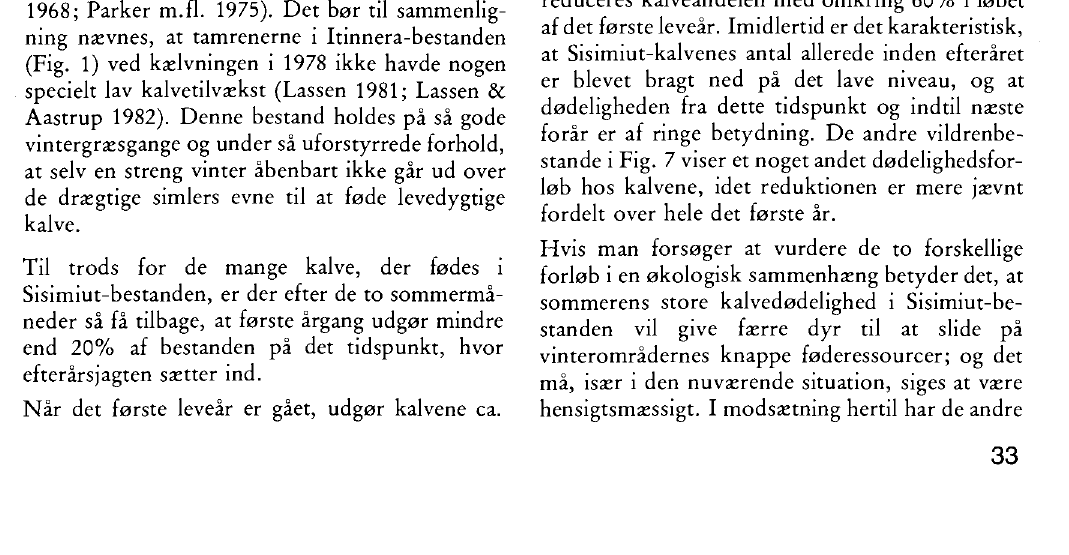
Fig. 7. Det gennemsnitlige kalv/simle forhold i Sisimiut- bestanden og i 12 forskellige vildrenbestande fra Canada, Alaska og Norge samt ændringer gennem første leveår. Ternede søjler = Sisimiut-bestanden. Prikkede søjler = 12 forskellige bestande fra Canada, Alaska og Norge. Fig. 7. Average calf/cow ratio in the Sisimiut population (chequered) and in various wild Rangifer populations (dotted) (Canada, Alaska, and Norway) and the reduction during the first year oflife.